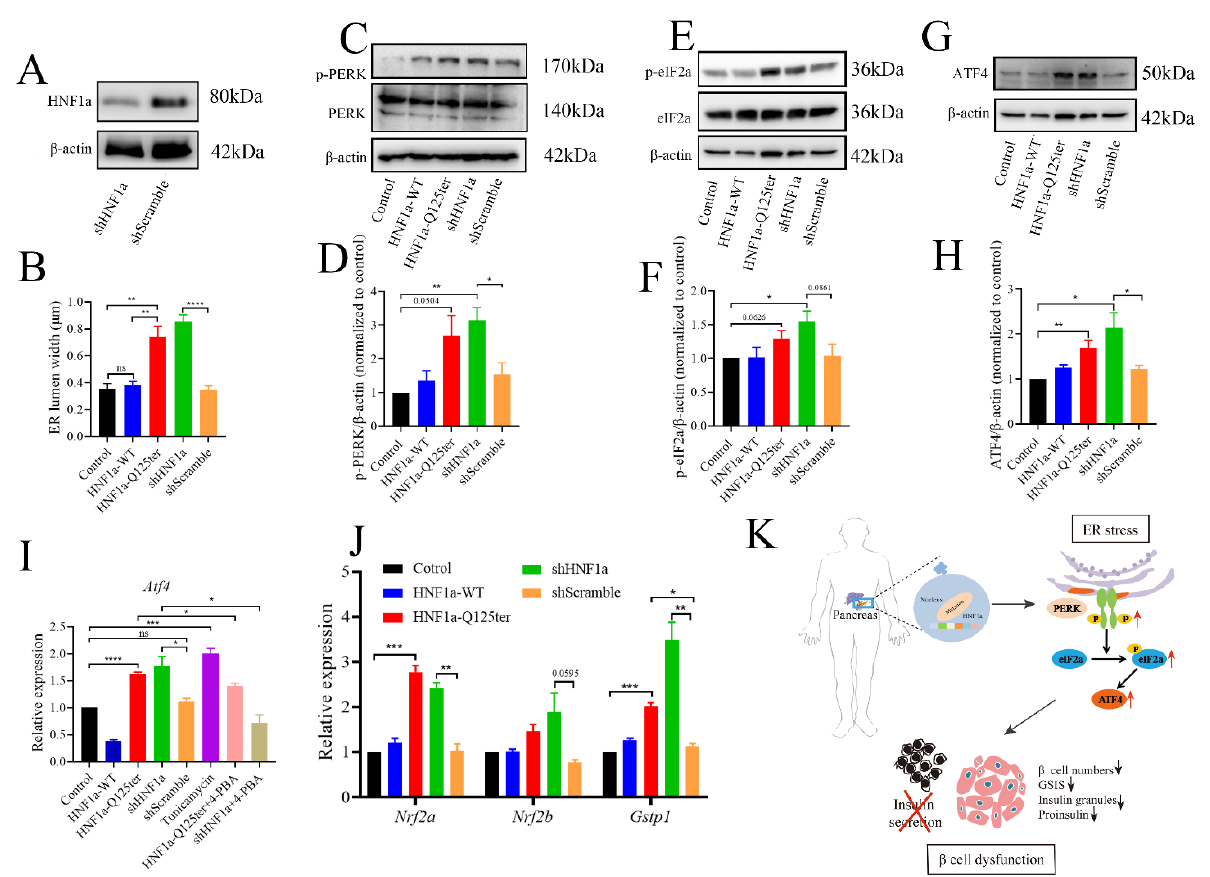
Figure 5. HNF1a-Q125ter induced ER stress through PERK/eIF2a/ATF4 signaling pathway. ( A ) Western blot of HNF1a in Ins-1 cells transfected with shHNF1a or control construct for 24 h. ( B ) Quantification of ER lumen width for control, HNF1a-WT, HNF1a-Q125ter, shScramble, and shHNF1a transfected Ins-1 cells, at least 15 different locations of the same cell were measured, n = 5 individual cells for each group. ( C,D ) Representative Western blot images ( C ) and quantification analysis ( D ) of p-PERK and PERK in different plasmids transfected Ins-1 cell. ( E , F ) Representative Western blot images ( E ) and quantification analysis ( F ) of p-eIF2a and eIF2a in different plasmids transfected Ins-1 cell. ( G , H ) Representative Western blot images ( G ) and quantification analysis ( H ) of ATF4 in different plasmid-transfected Ins-1 cell. Protein levels were normalized to β -actin. ( I ) RT- qPCR analysis of the expression levels of Atf4 mRNA level in different plasmids transfected Ins-1 cell. The tunicamycin treatment (5 μg/mL) was used as a positive control for ER stress, and chemical chaperone 4-PBA (300 μm/L) was used as an ER-stress reliever. ( J ) RT-qPCR analysis of the expression levels of Nrf2a, Nrf2b, and Gstp1 mRNA levels in different plasmids transfected Ins-1 cell. ( K ) Working model for the molecular mechanism of new HNF1a variant resulted in β -cell dysfunction. A schematic that showed how the new variant of HNF1a resulted in MODY3. HNF1a-Q125ter induced ER stress through upregulated p-PERK/p-eIF2a/ATF4 and resulted in β -cell dysfunctions, including decreased β -cells numbers, decreased insulin expression, reduced insulin granules, and impaired insulin secretion. Results are represented as means with standard errors; * p < 0.05, ** p < 0.01, *** p < 0.001, and **** p < 0.0001. One-way ANOVA. All experiments were conducted at least three times. WT, wild type; ER, endoplasmic reticulum; PERK, protein kinase R-like ER kinase; eIF2a, eukaryotic initiation factor 2; ATF4, activating transcription factor